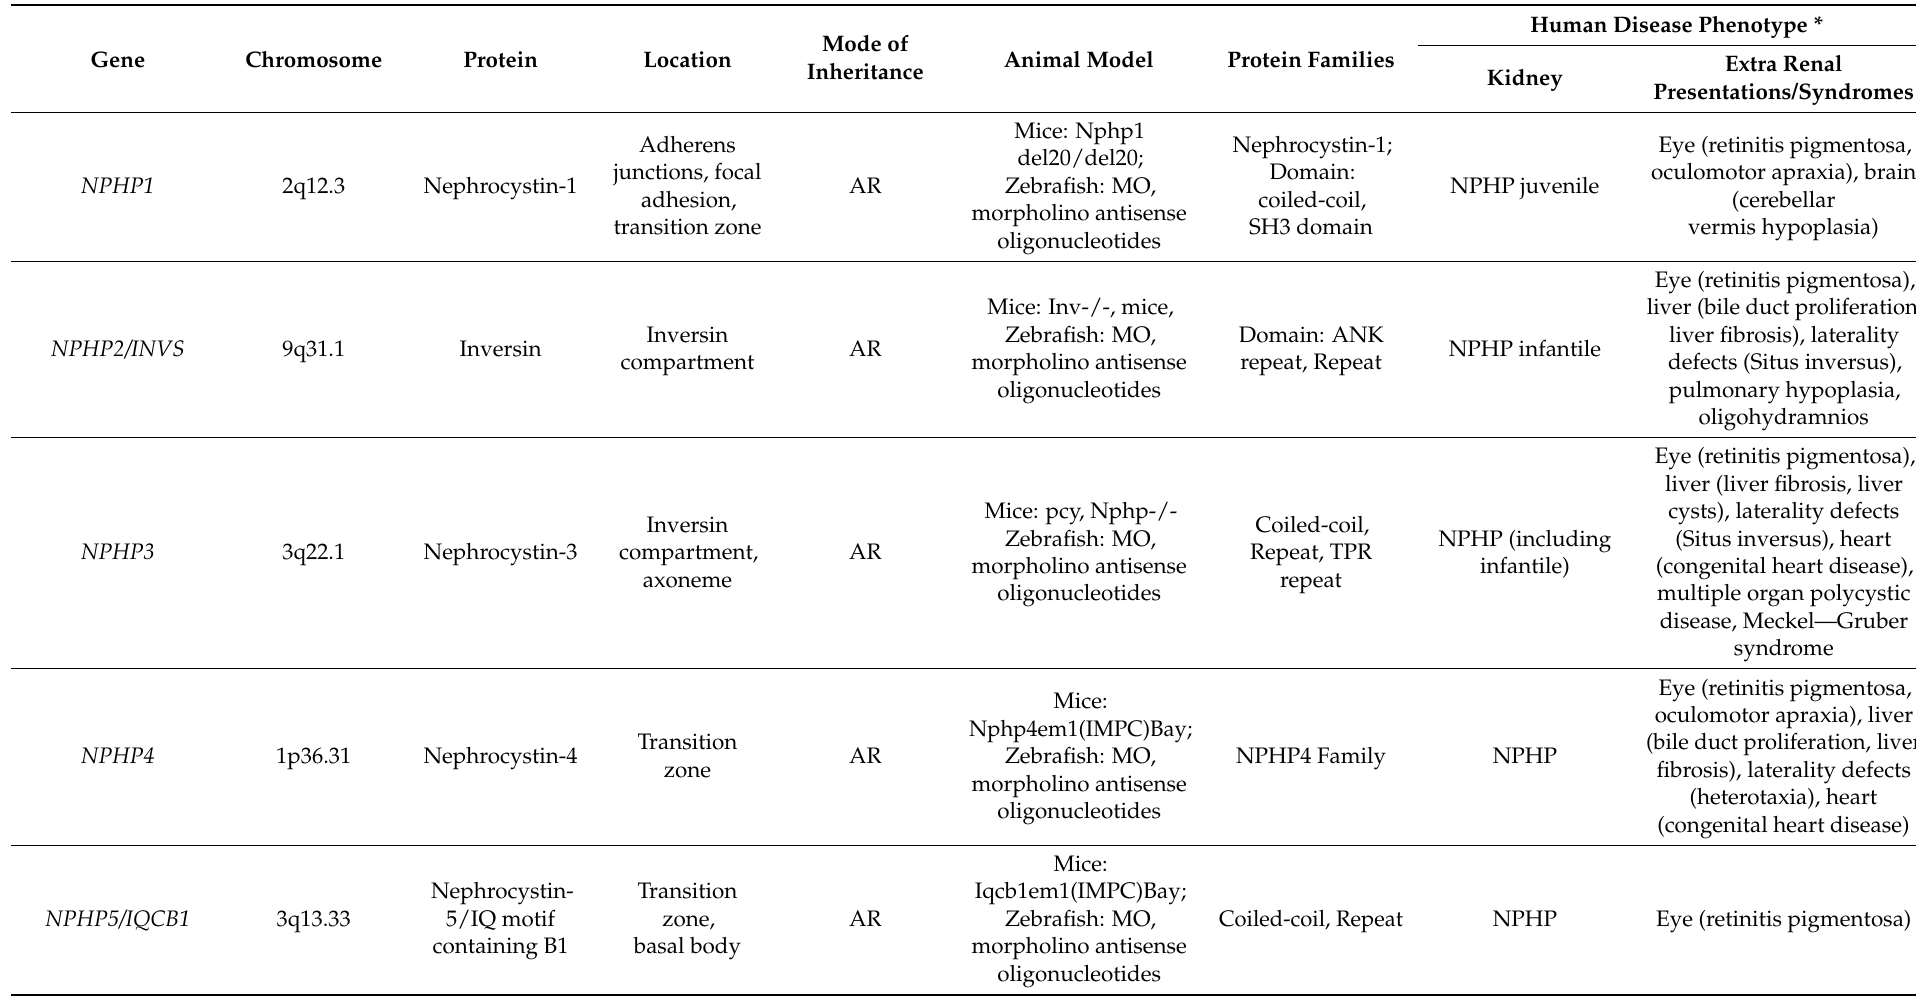
Table 1. Monogenic genes causing NPHP and their phenotypic spectrum from associated